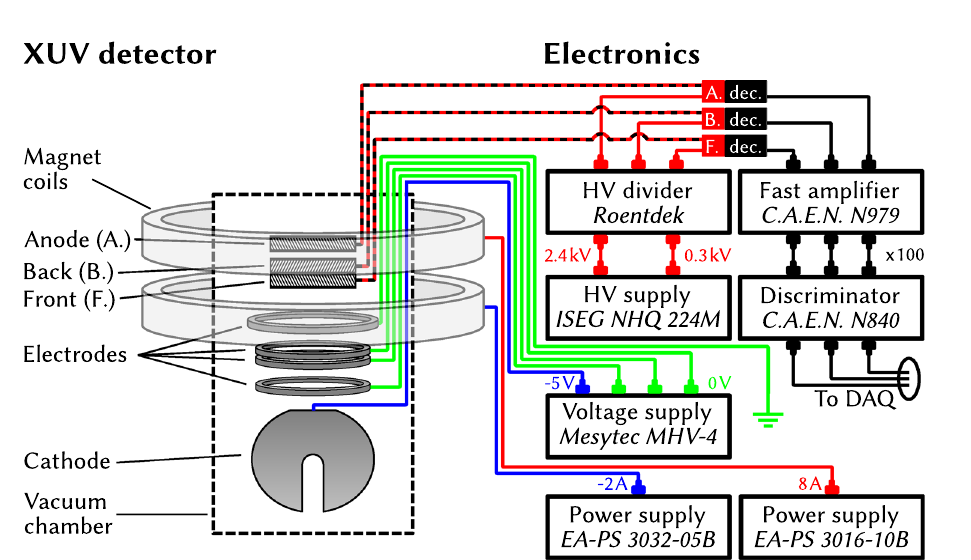
Figure 3. Left: schematic view of the XUV detection system with movable cathode (1), electrodes (2), magnet coils (3), magnetic field lines (4) and MCP (5). Right: cathode plate with 300 nm CsI coating.